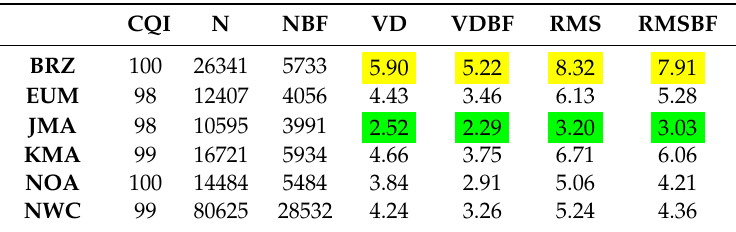
Table 15. Experiment 2: Comparison of all AMVs to NWP analysis winds, with a CQI threshold so that at least 10,000 AMVs are kept. (CQI = Common Quality Indicator Threshold used for each center; N = Number of AMVs; NBF = Number of AMVs with Best-Fit Pressure Value; VD = Vector Difference for all AMVs; VDBF = Vector Difference for AMVs with Best-Fit Pressure Value; RMS = Root Mean Square Error for all AMVs; RMSBF = Root Mean Square Error for AMVs with Best-Fit Pressure Value). The extremes for each category are highlighted; in yellow, the worst value, and in green, the best value.